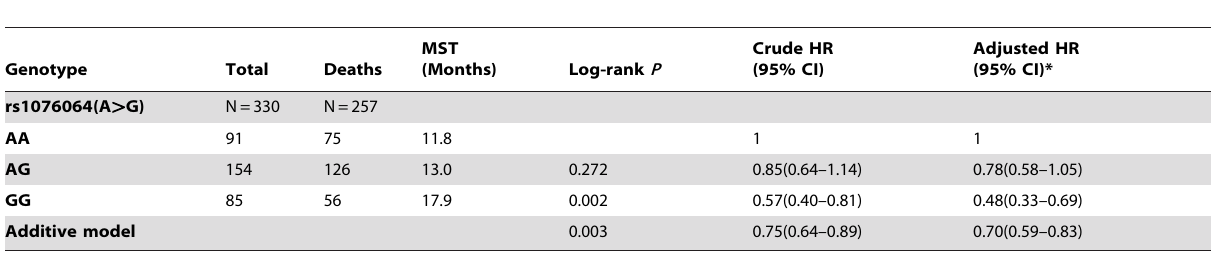
Table 2. Genotypes of miR378 polymorphisms and HCC